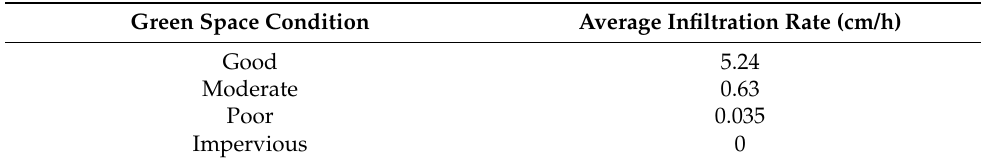
Table 1. Average infiltration rates for green space categories. Green Space Condition Average Infiltration Rate (cm/h) Good 5.24 Moderate 0.63 Poor 0.035